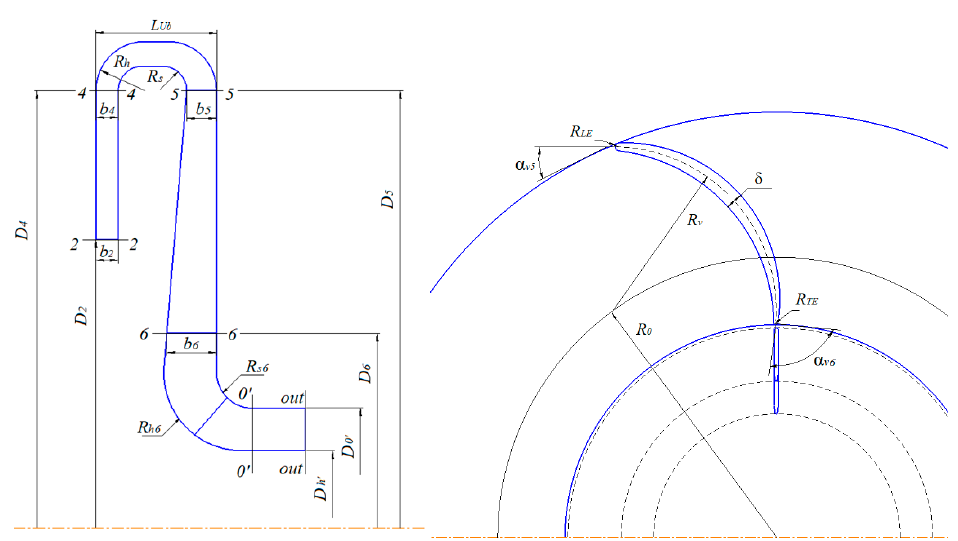
Figure 1. Stator part of the stage after preliminary design.